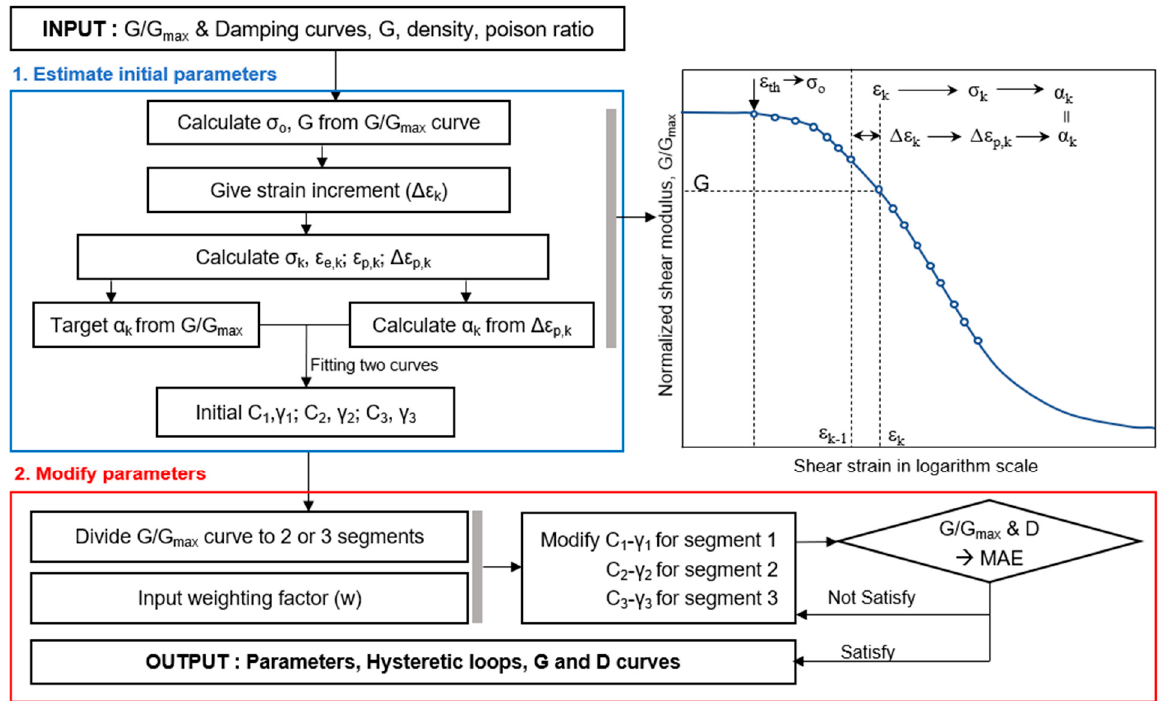
Figure 7. Flowchart for estimating NKH model parameters.